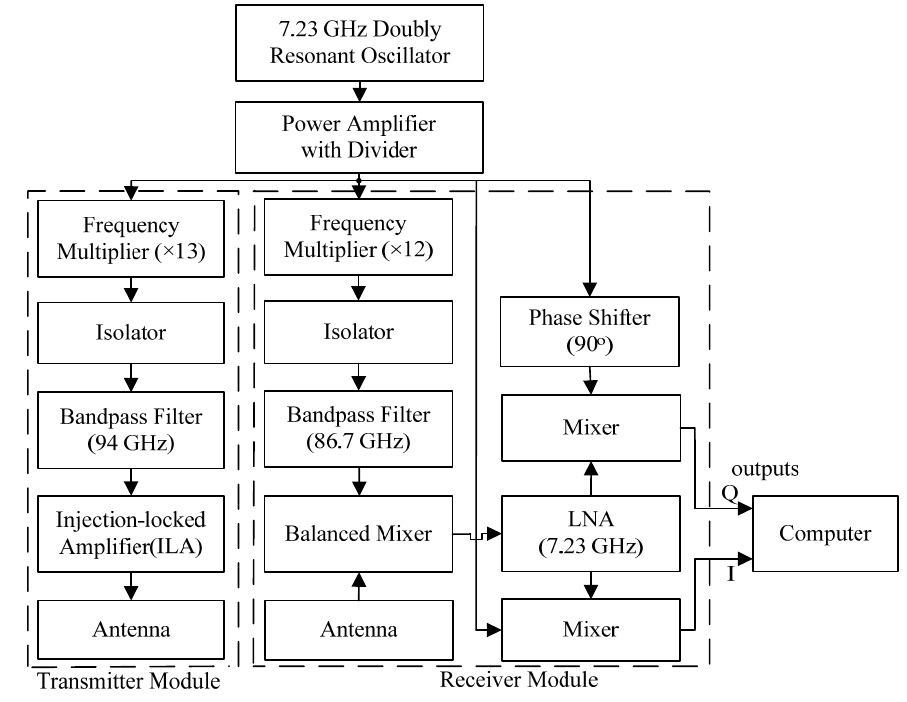
Figure 1. Schematic diagram of the 94 GHz millimeter wave radar sensor.